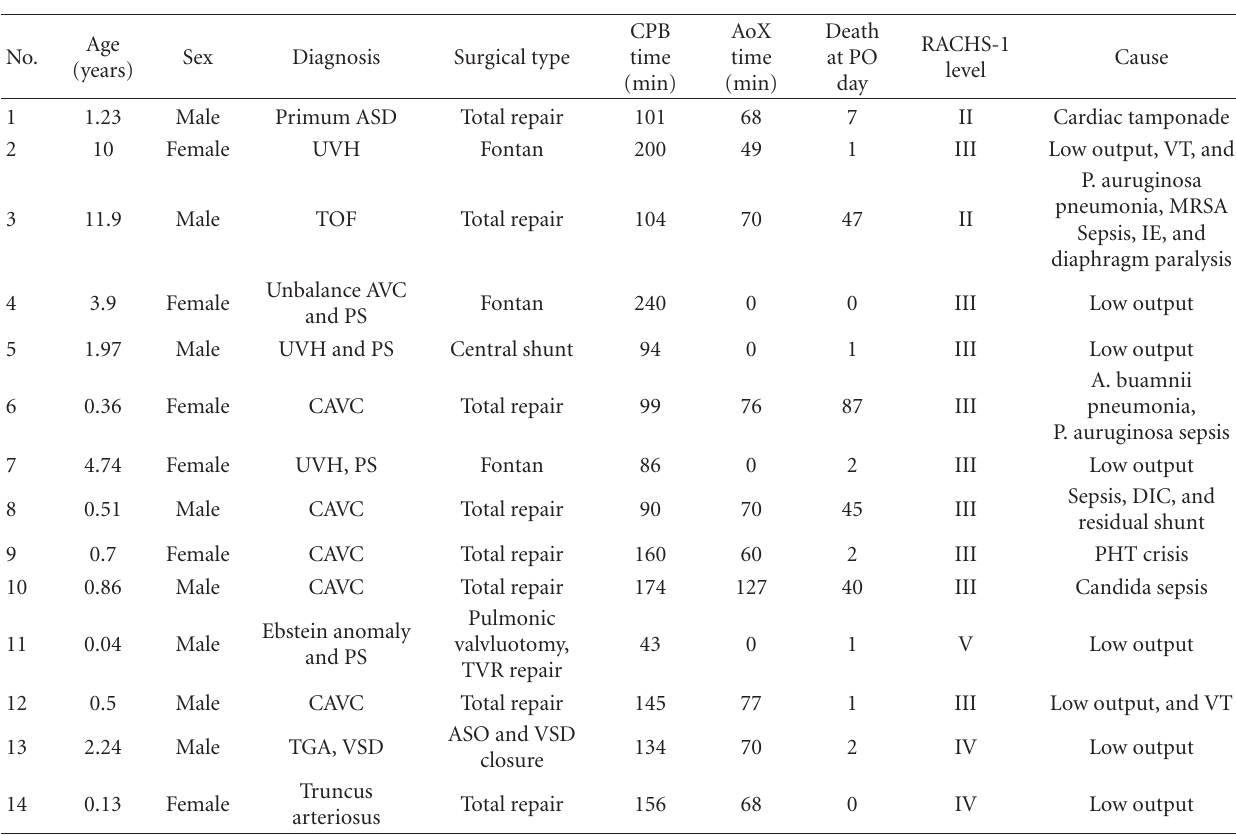
Table 4: Summary of discharge mortality